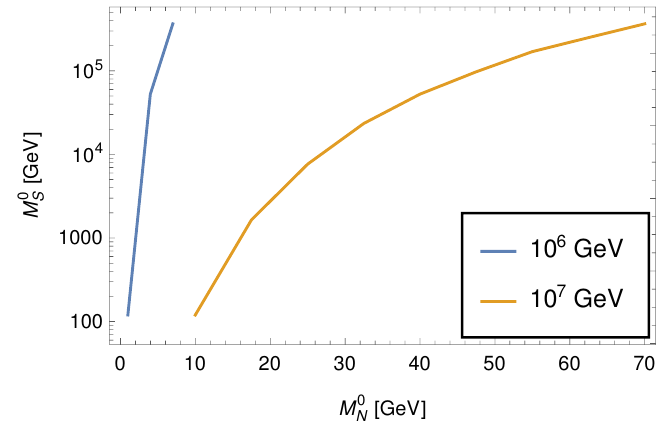
Figure 6. Scalar zero-temperature mass versus sterile neutrino zero-temperature mass. Under the assumption of a value for v 0 , successful leptogenesis limits the two masses above the corresponding S colored